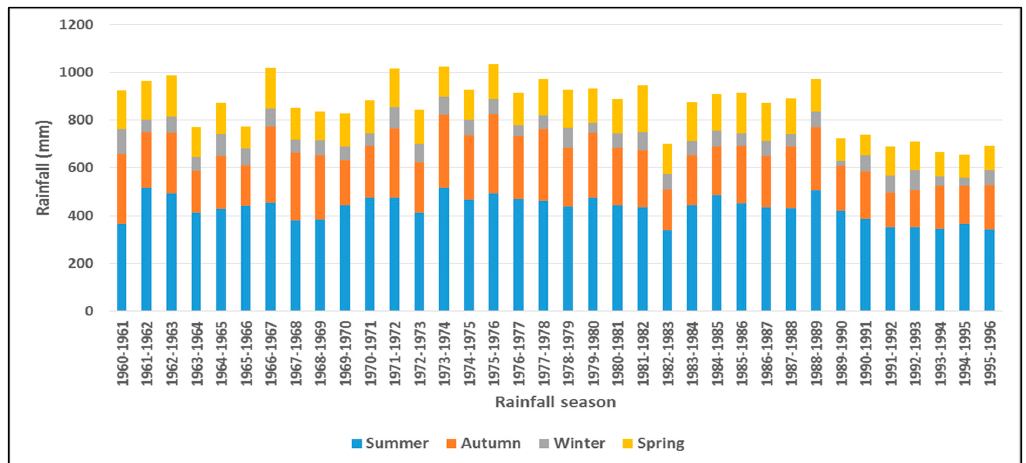
Figure 3. Temporal change in annual and seasonal rainfall in the SADC region from 1960 to 1996. Source: Developed by authors.